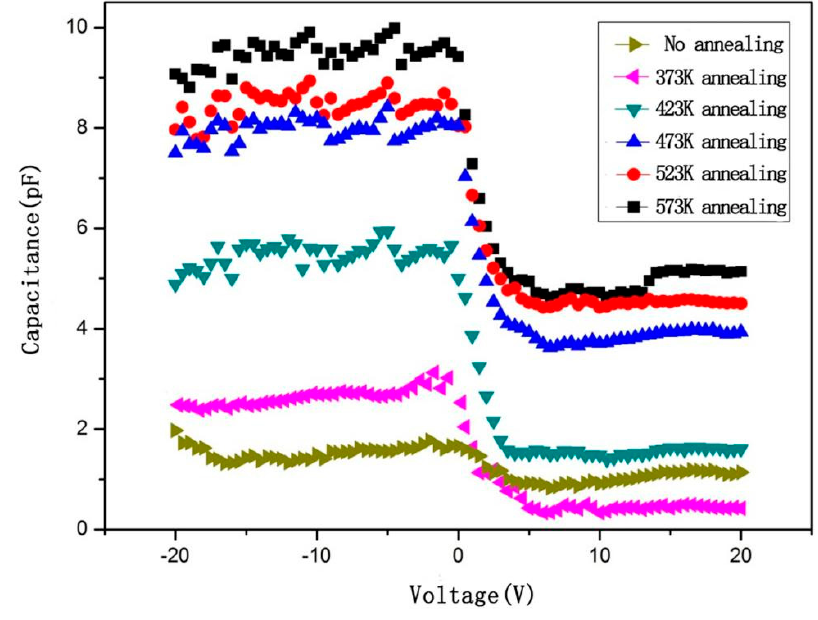
Figure 6. The C–V curves of the Ti-Au/CdZnTe sample after rapid annealing for 4 min at different temperatures. Table 4. The barrier heights of Ti-Au/CdZnTe after rapid annealing at different temperatures for 4 min.